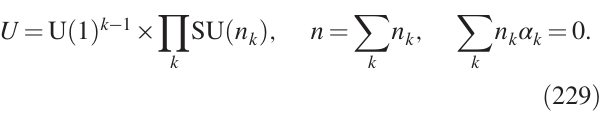
SO(10) (Table IV), and SO(11) and Sp(5) (Table V). Looking at Table IV, one might think that U ¼ SO ð 6 Þ × U ð 1 Þ 2 and U ¼ U ð 4 Þ × U ð 1 Þ are the same because so ð 6 Þ and su ð 4 Þ are identical Lie algebras. They are not. The spectrum of the 14 type- B NGBs on SO ð 10 Þ = ½ SO ð 6 Þ ×